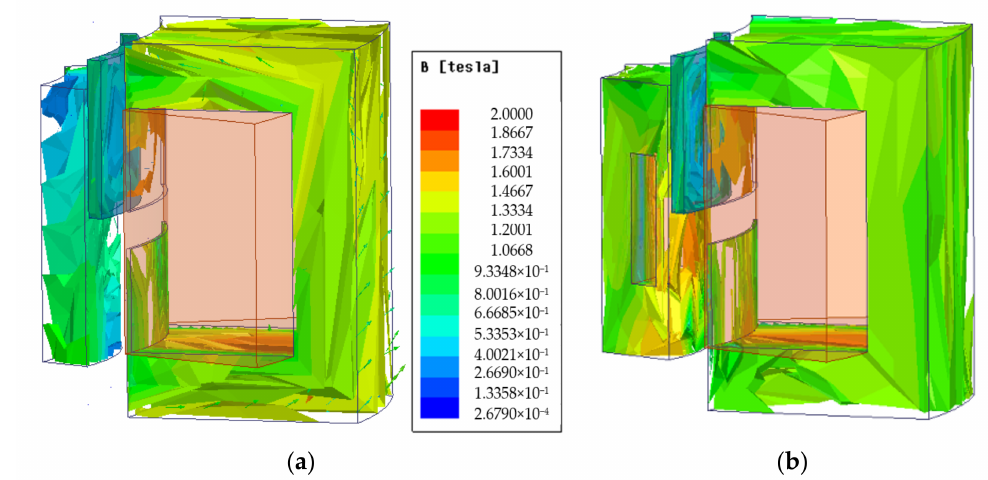
Figure 4. Loaded flux density distributions: ( a ) Conventional model 1; ( b ) Proposed model 2.